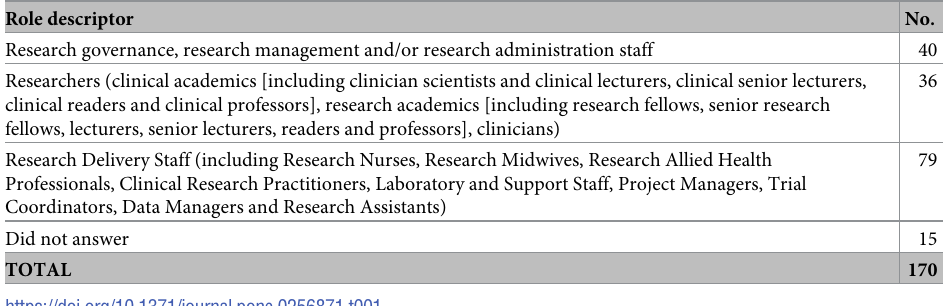
Table 1. Questionnaire participants by role descriptor.